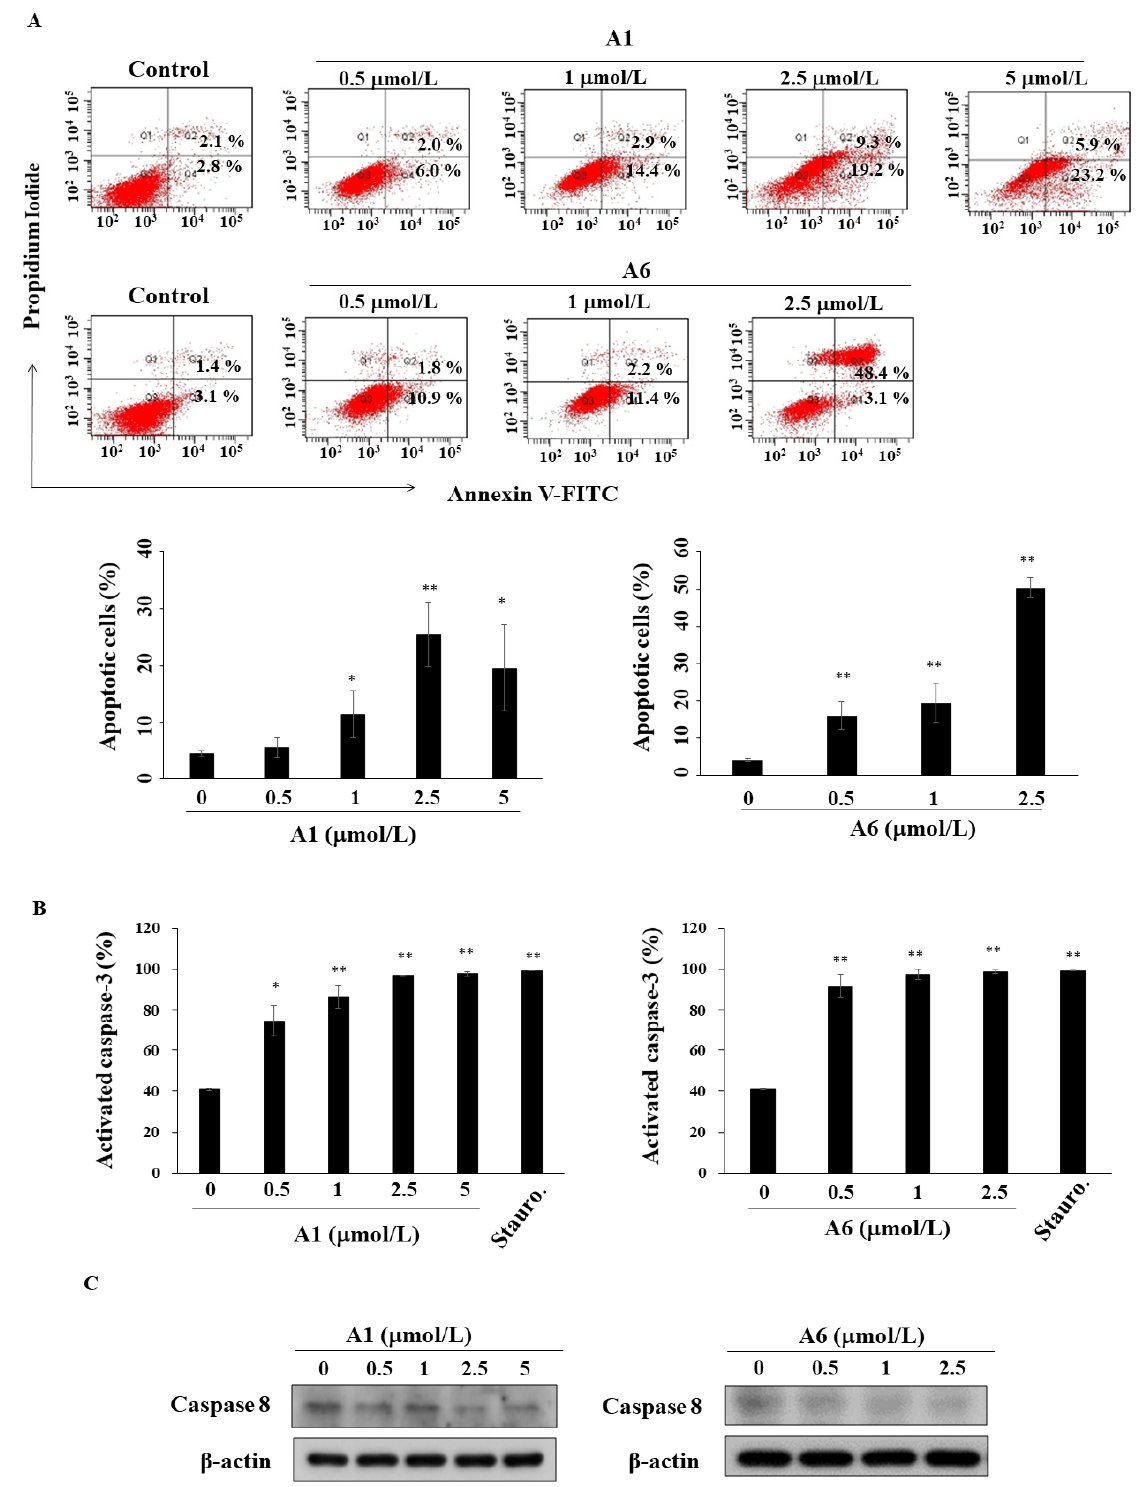
Figure 4. A1 and A6 induce apoptosis in Hep3B cells. ( A ) Upper panel, flow cytometric analysis of apoptotic cells after treatment with A1 or A6 for 48 h in Hep3B cells. Lower panel, statistical analysis of apoptotic cells after treatment with A1 or A6 in Hep3B cells. Points , means; bars , S.D. ( n = 3). * p < 0.05, ** p < 0.01. ( B ) Caspase-3 activation by A1 and A6 in Hep3B cells using flow cytometry. Saturosporine (Stauro., 25 nmol/L) was used as a positive control. Points , means; bars , S.D. ( n = 3). * p < 0.05, ** p < 0.01. ( C ) Effects on caspase-8 after treatment with A1 and A6.